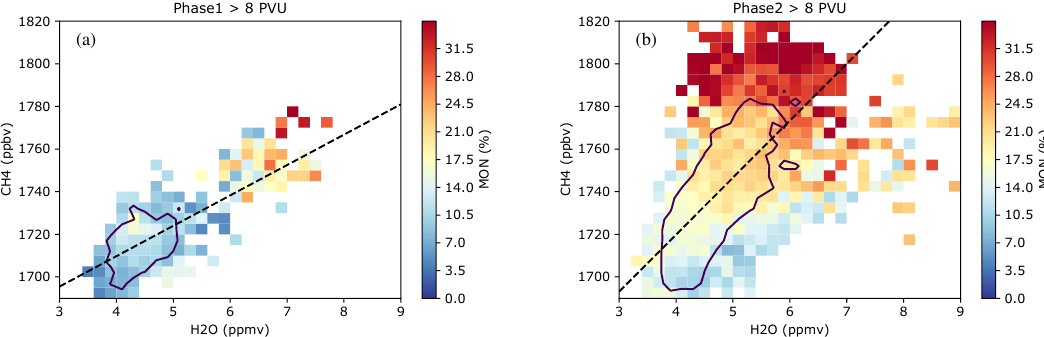
Figure 5. Correlation of water vapor and methane for PV > 8PVU, color-coded by the Asian monsoon surface tracer MON: (a) for phase 1 (August) and (b) for phase 2 (September). The solid black line marks the core region, which encompasses 75% of the data. The black dashed line represents a robust linear regression fitting curve (Theil–Sen